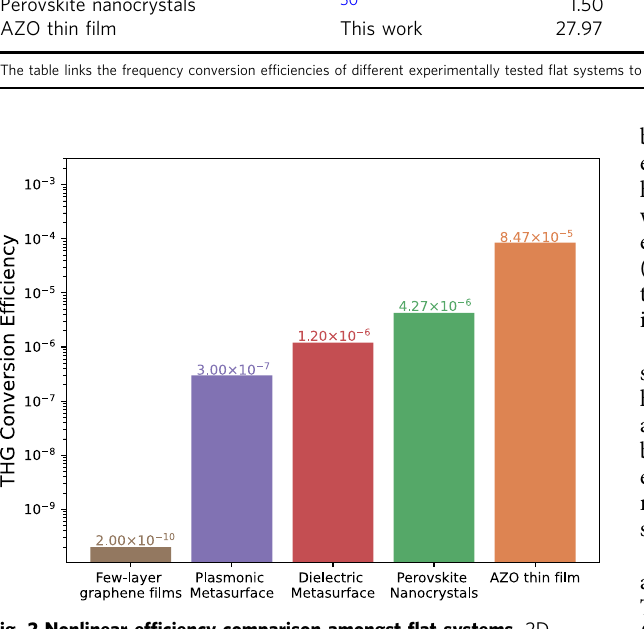
Fig. 2 Nonlinear ef fi ciency comparison amongst fl at systems. 2D